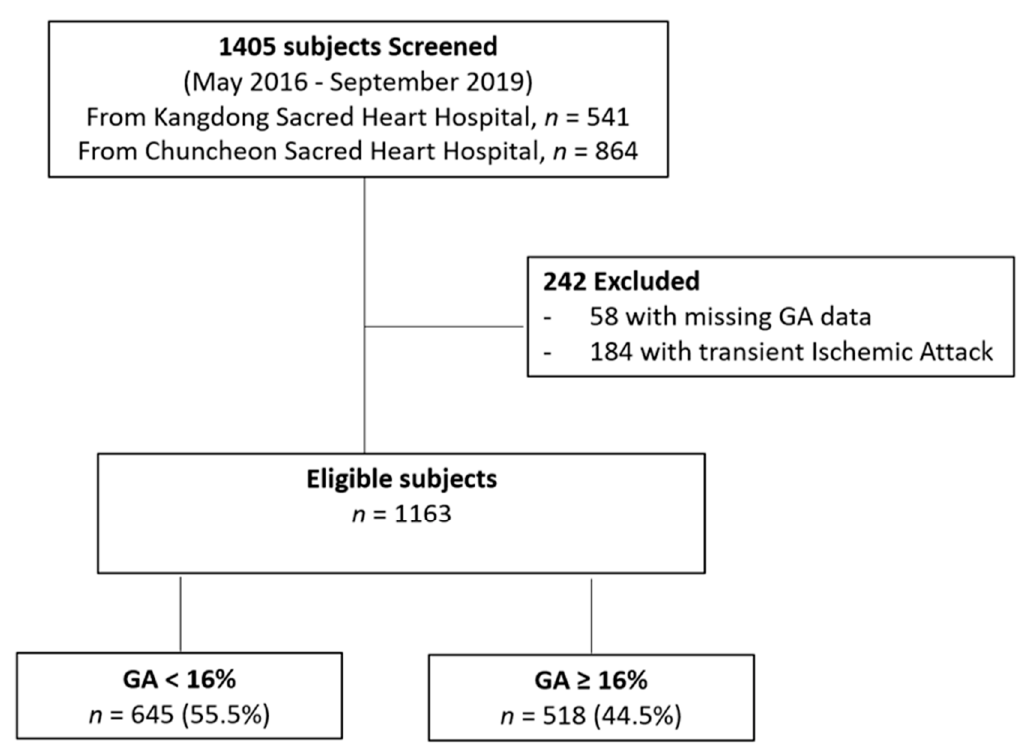
Figure 1. Flow diagram of study population. GA, glycated